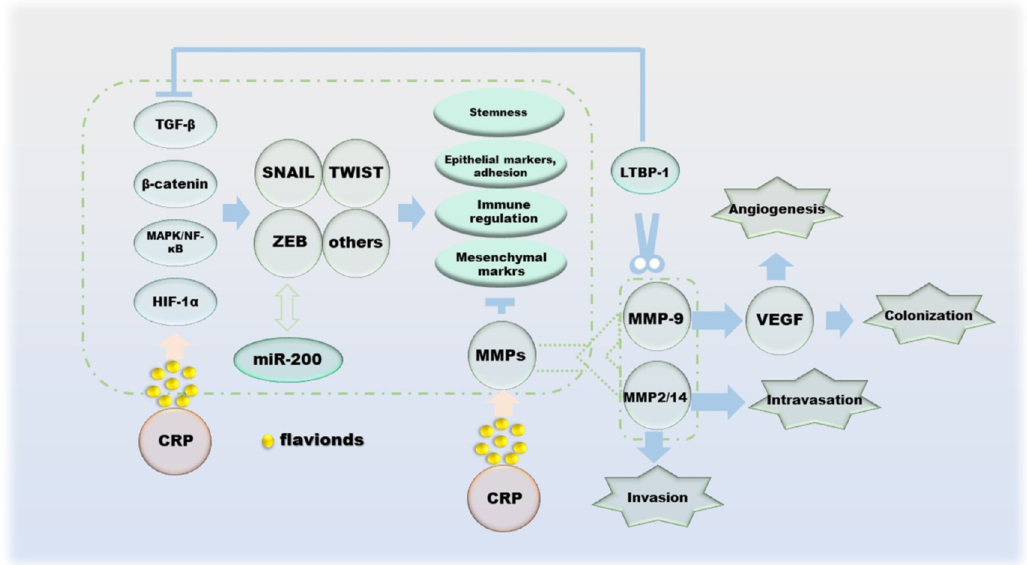
Figure 6. The effect of CRP during the migration of cancer cells.